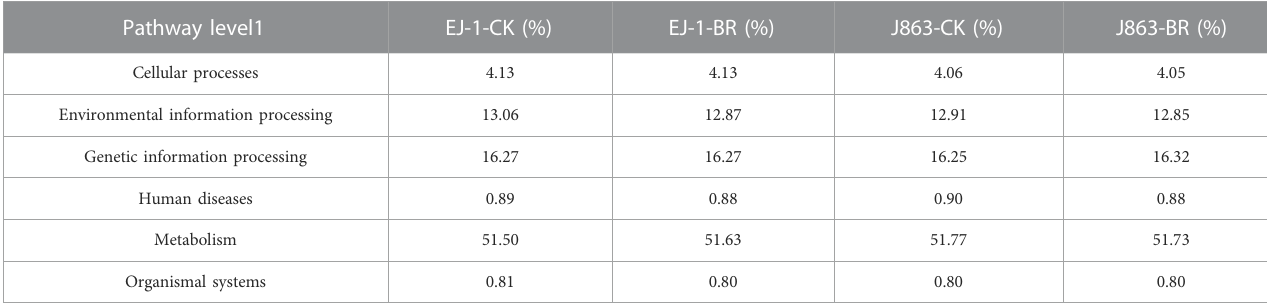
TABLE 2 The proportion of predicted functional pro fi les in different treatments (Pathway level